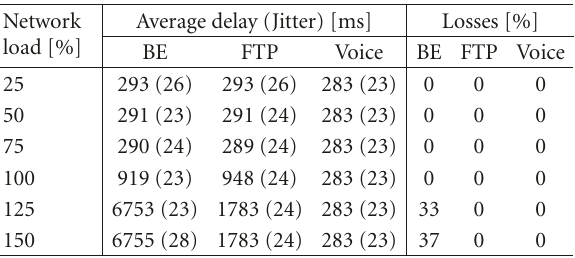
Figure 7: Dynamic change of class of service using the QoS agent. Table 3: SATIP6 QoS performance under di ff erent loading condi- tions.